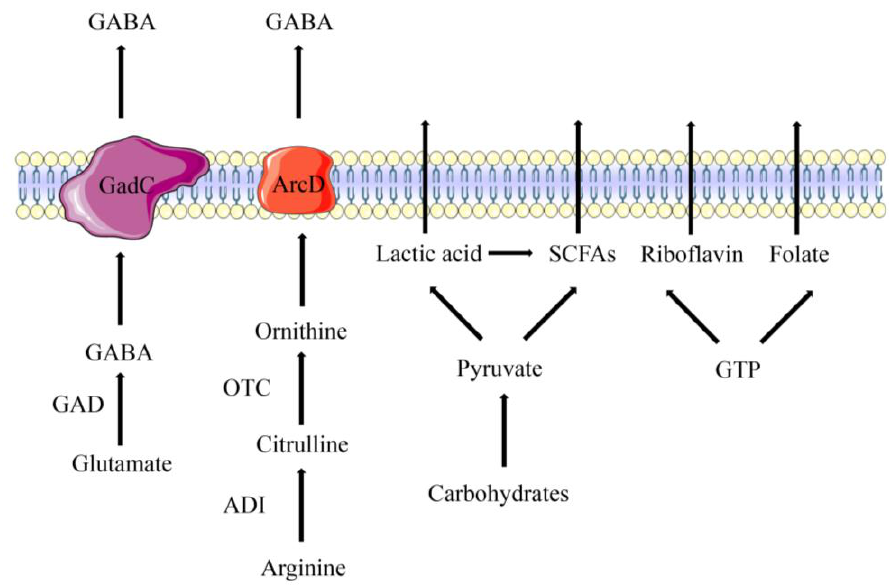
FIGURE 1: Synthesis of amino acids, organic acids and vitamins in LAB. Apart from extracellular polysaccharides and bacteriocin, the synthetic pathways of